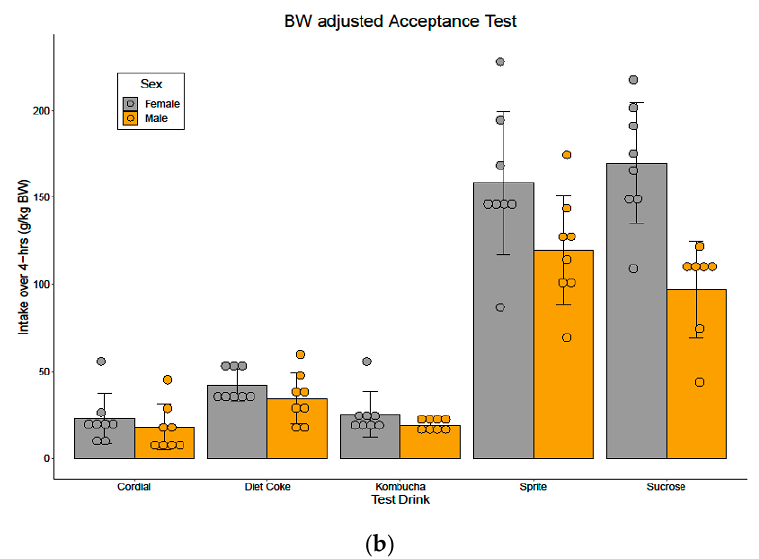
Figure 3. ( a ) Acceptance tests performed in female and male naïve animals (Test 1 pre-sucrose) and following 4 weeks of sucrose exposure (Test 2 post-sucrose) during Phase 1. Mean intake (mL ± SEM) of the test drinks during a 4 h acceptance test showed female and male rats drank significantly higher amounts of sucrose and Sprite compared to Diet Coke, Cordial and Kombucha, p < 0.001, which had similar intakes. Sucrose and Sprite intakes increased following 4 weeks of sucrose expo- sure ( p < 0.05) in both sexes. ( b ) BW-adjusted acceptance test in female and male naïve animals dur- ing Phase 1. Mean intake (g/kg BW) was significantly higher in female rats in the sucrose and Sprite groups ( p < 0.05) ( n = 8/sex/group; n = 7 males in the sucrose group).